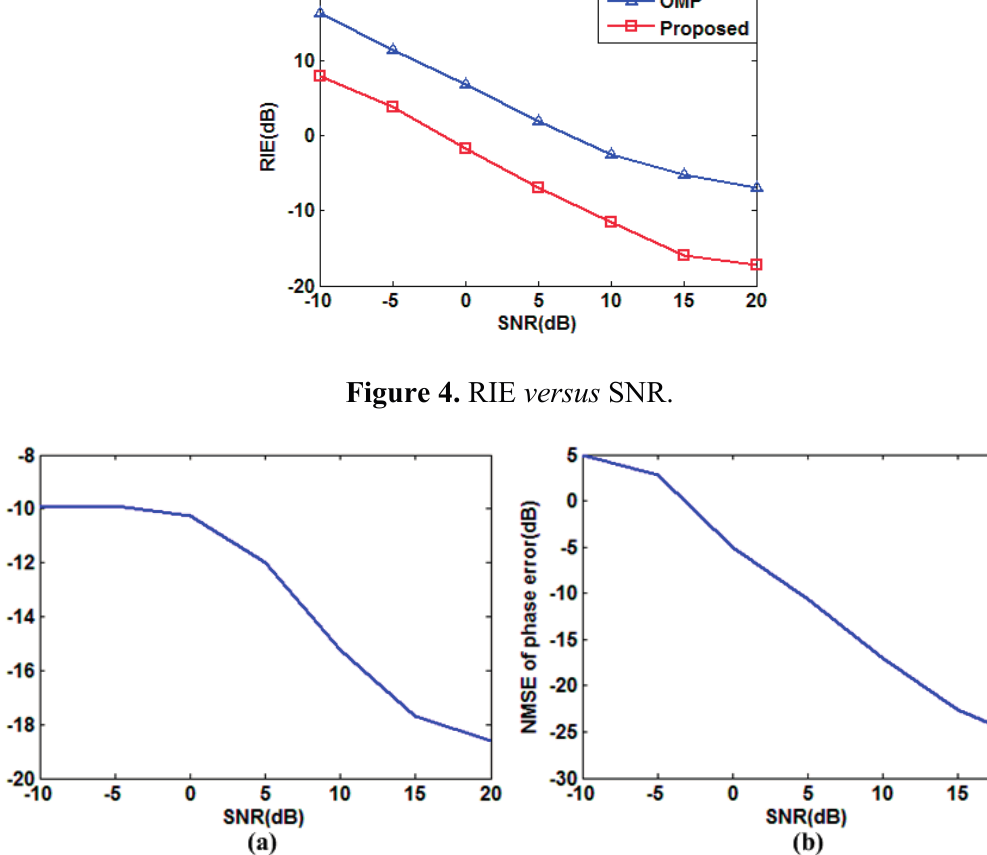
Figure 5. Gain-phase error estimation performance for various SNRs. ( a ) NMSE for gain error estimation versus SNR; ( b ) NMSE for phase error estimation versus